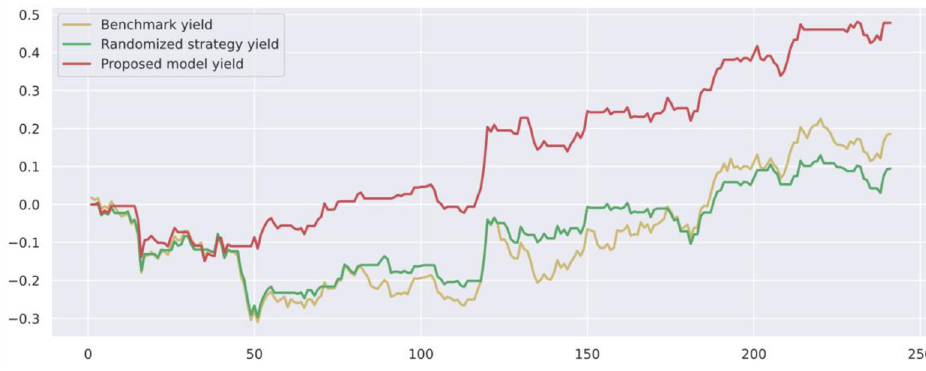
Fig 11. Ping An Bank stock strategy